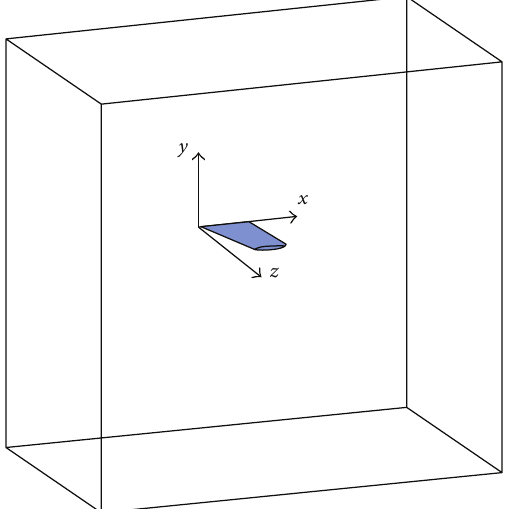
Figure 2: Sketch of the computational